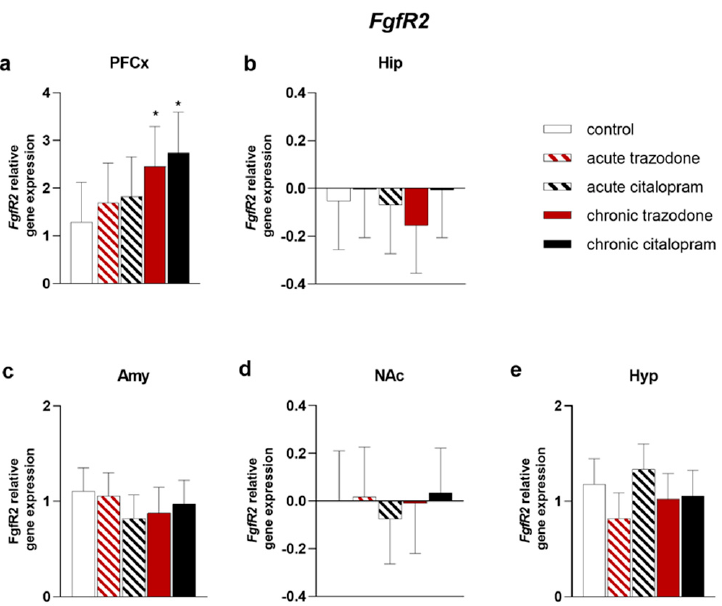
Figure 4. mRNA levels of Fgfr2 in the PFCx ( a ), Hip ( b ), Amy ( c ), NAc ( d ), and Hyp ( e ) after acute or chronic treatment with trazodone, citalopram, or vehicle. The least square predicted means with 95% confidence intervals are plotted. Data were log-transformed when required to stabilise the variance and satisfy the parametric assumptions ( b , d ). *: p < 0.05 in the Planned Comparison vs. control. n = 6/group.